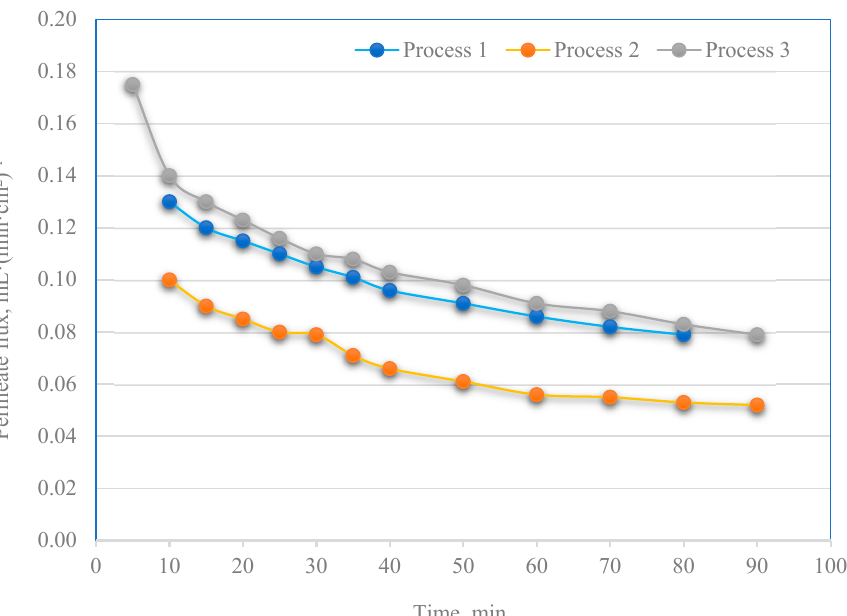
Figure 7. PPW permeate flux vs. time obtained on the new (process 1) and regenerated (process 2 and 3) membrane (0.4 MPa).